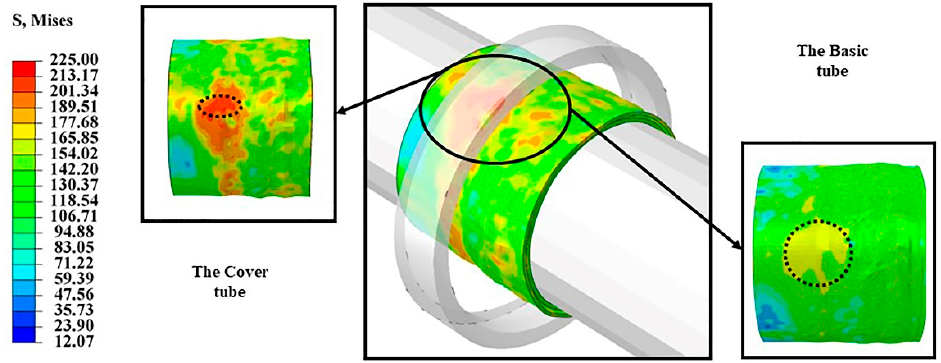
Figure 3. Equivalent stress distribution during rotary ring spinning of bimetallic tube.